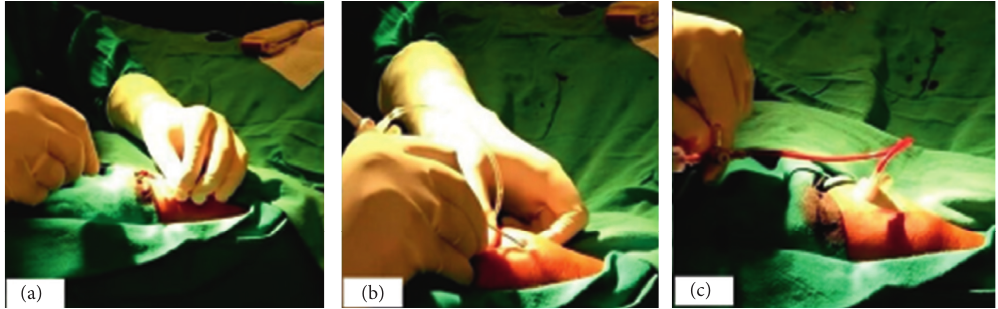
Figure 2: (a): Guidewire inserted via Seldinger technique, (b) arterial sheath inserted over the wire, and (c) arterial backflow in sheath noted.